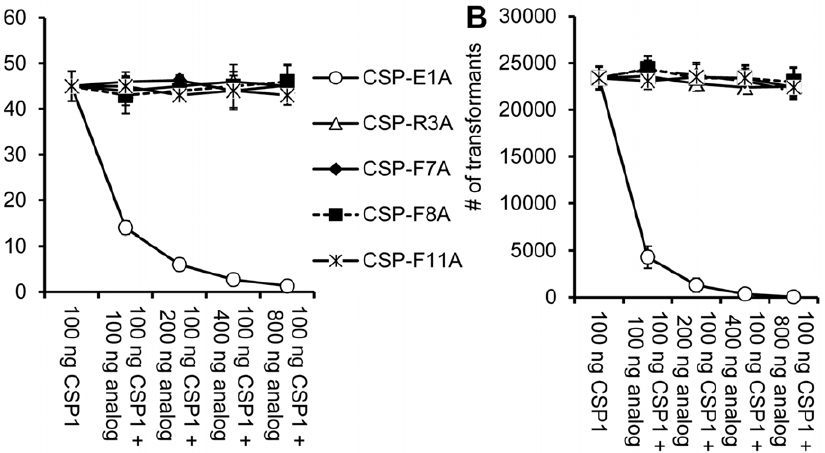
Figure 3. CSP1-E1A is uniquely able to inhibit the expression of comX and genetic transformation. (A) CSP-E1A competitively inhibits CSP1-mediated induction of comX in a dose dependent manner. D39pcomX::lacZ cells were exposed to 100 ng/ml of CSP1 alone or simultaneously with increasing concentrations of each CSP1 analog. The activity of the comX gene promoter was measured by b -galactosidase activity. (B) CSP-E1A competitively inhibits CSP1-mediated genetic transformation. Genetic transformation was performed using 30 m g/ml of the D39 genomic DNA containing the rpsL gene. Transformants were selected on THB agar containing 100 m g/ml streptomycin. Experiments were performed in triplicates and repeated three times. The means 6 SD of one typical experiment are shown.